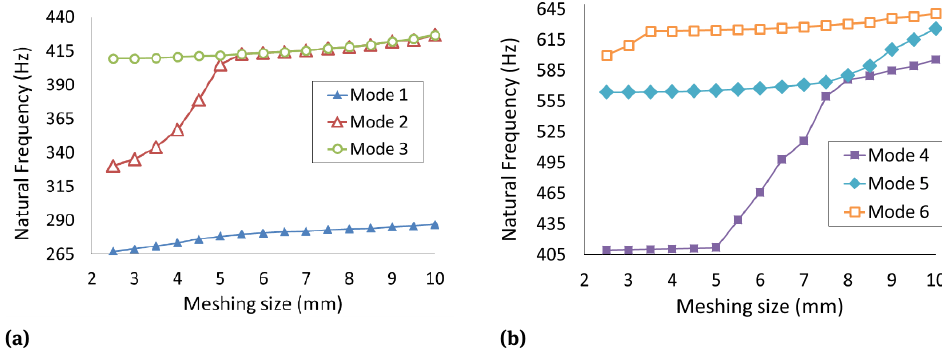
Figure 5: Convergence analysis for 5% damaged ship sandwich plate: (a) the first, second, and third mode, (b) the fourth, the fifth, and the sixth